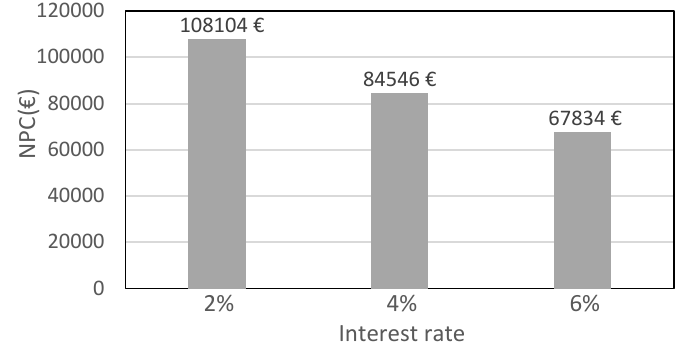
Figure 7. PV + Diesel systems. Optimal solutions include cases with a PV cost of 1 €/Wp.